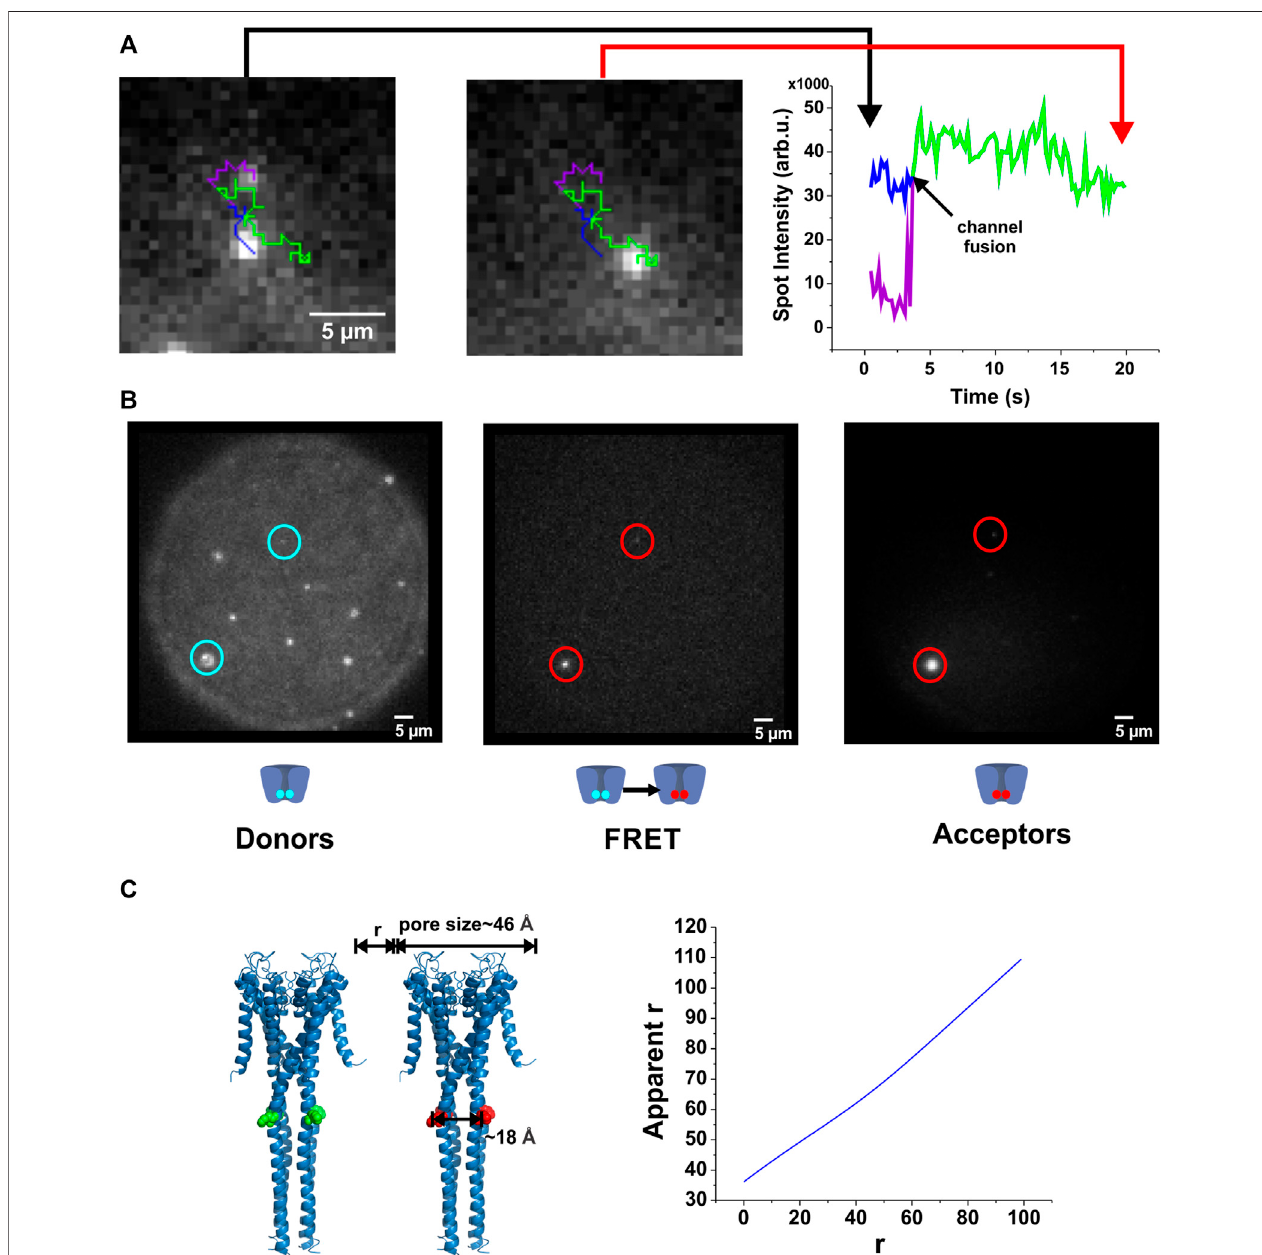
FIGURE 3 | Direct observation of KcsA clustering. (A) , By tracking the fl uorescence of individual spots, their interaction has been assessed. When two channels fuse, the channels remain in close contact and the total intensity corresponds to the sum of the individual spots. (B) , FRET occurs between co-localized channels. KcsA channels were labeled either with AlexaFluor-488-C 5 -maleimide (donor) or AlexaFluor-647-C 2 -maleimide (acceptor). As the R 0 of this fl uorescent pair is about 56 Å, we were able to evaluate the proximity from about 35 Å to 85 Å. Both populations were injected one after the other on the planar lipid bilayer. After a few minutes, co- localizeddonor-acceptorpairwasobserved( leftandrightpanels ),aswellasalowFRETsignal( middlepanel ),indicatingchannelproximity(correctedr)ofabout60 Å( n = 33). Our results suggest therefore that direct protein-protein interactions do not occur, although they assemble in closely packed microdomains. (C) . Illustration of the in fl uence of multi-labeling when evaluating distances by FRET measurements (see methods for details).